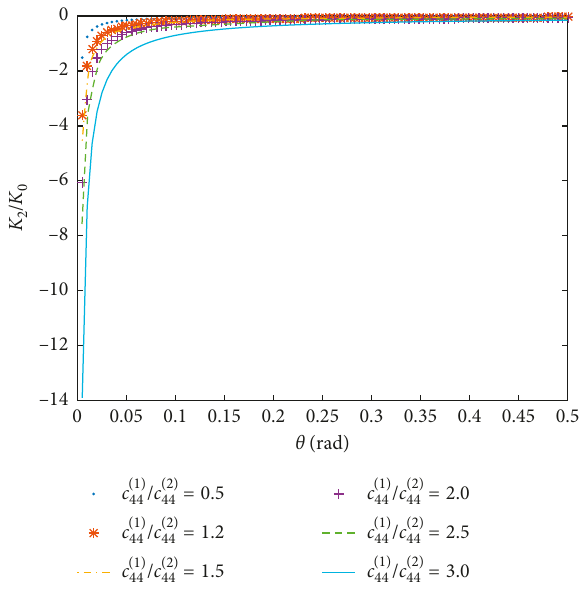
Figure 10: Relationship between IFs K values of the parameter c ( 1 )